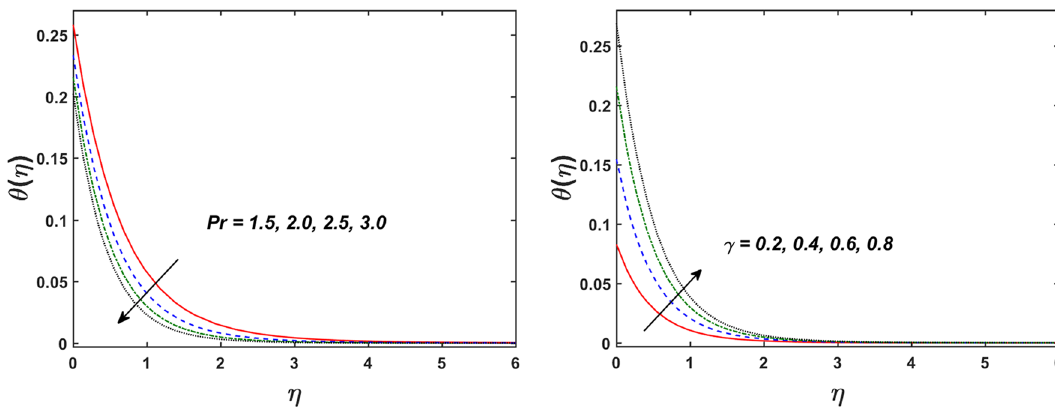
Figure 6. Variation in θ(η) for Pr and γ .